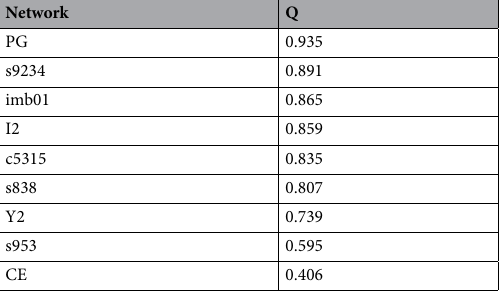
Table 3. VLSI circuits and other networks listed by their modularity (in decreasing order) estimated using the Louvain algorithm 48 for community